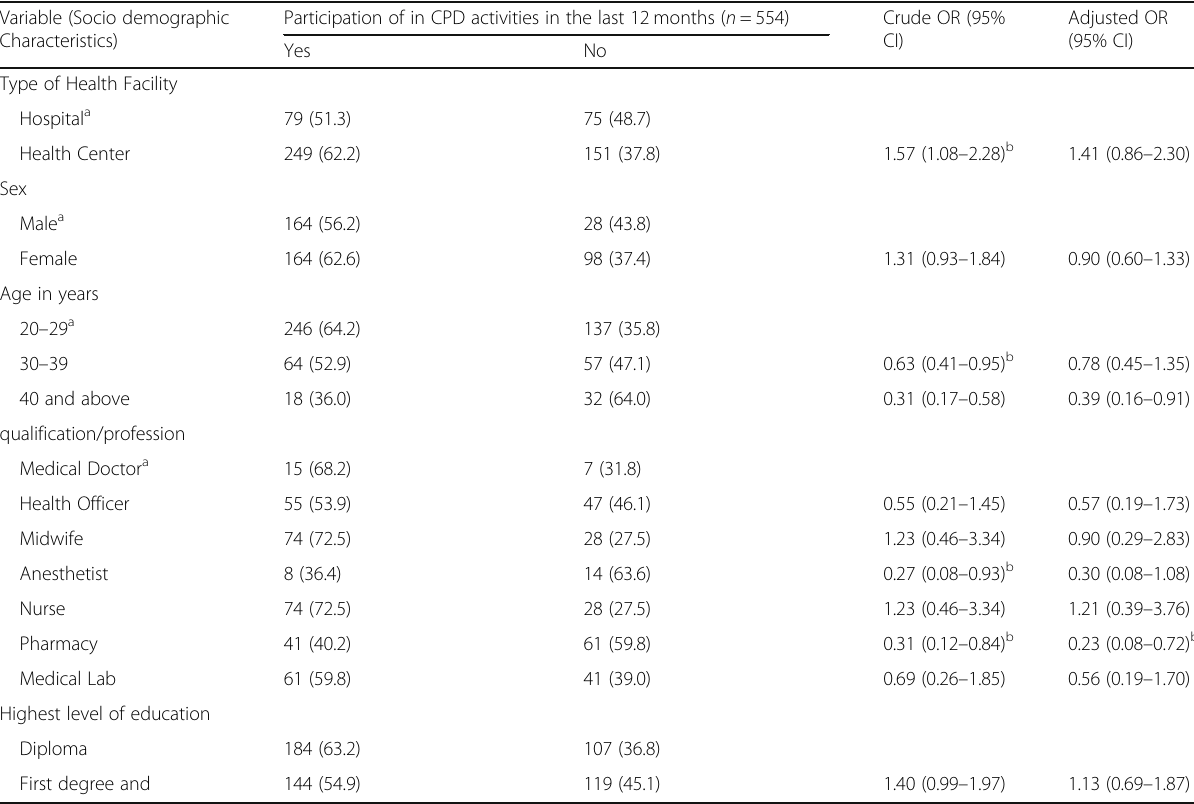
Table 6 Factoring affecting participation in CPD, exploring health workforce regulation practices and gaps, Ethiopia, March 2015 Variable (Socio demographic Participation of in CPD activities in the last 12 months ( n = Characteristics)